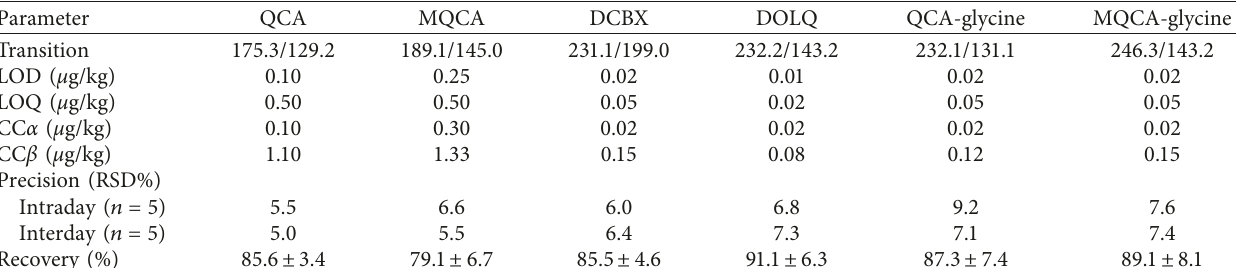
Table 4: Validation parameters related to the method of QCA, MQCA, DCBX, DOLQ, QCA-glycine, and MQCA-glycine in the swine